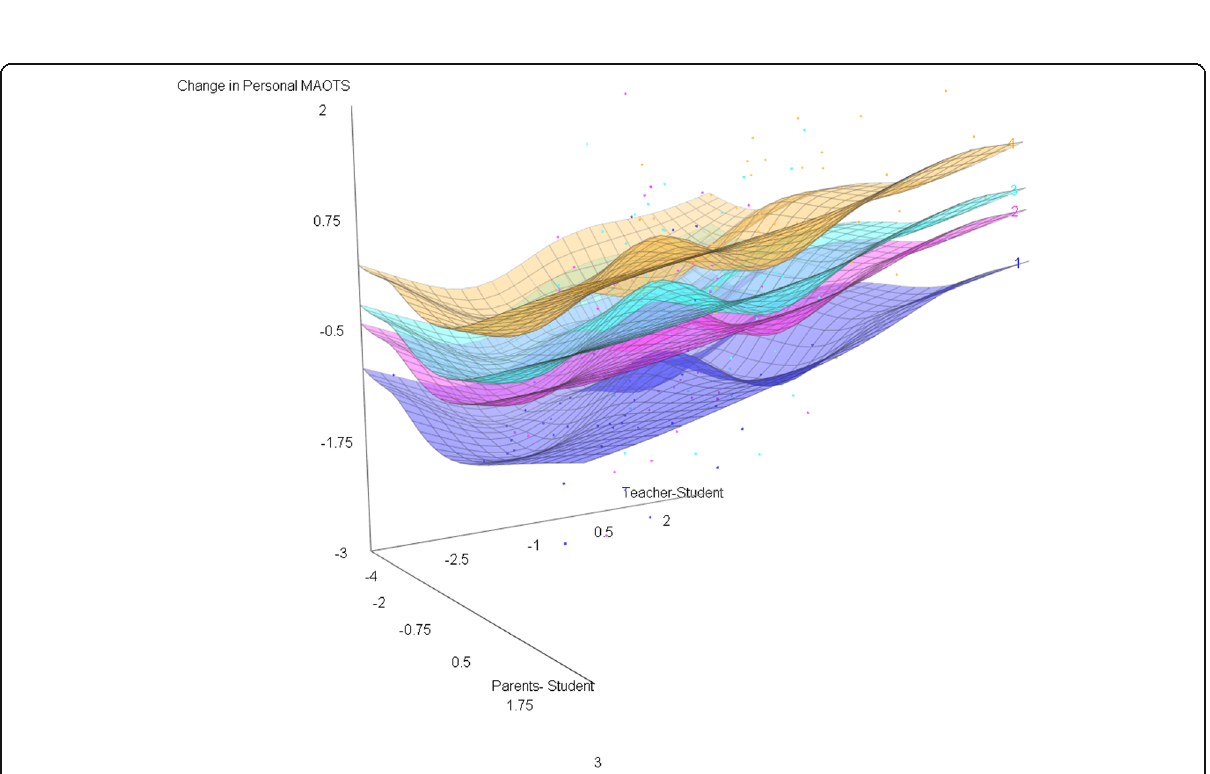
Fig. 4 Changes to girls ’ personal MAOTS vs. differences between perceived environmental emphases on MAOTS and personal